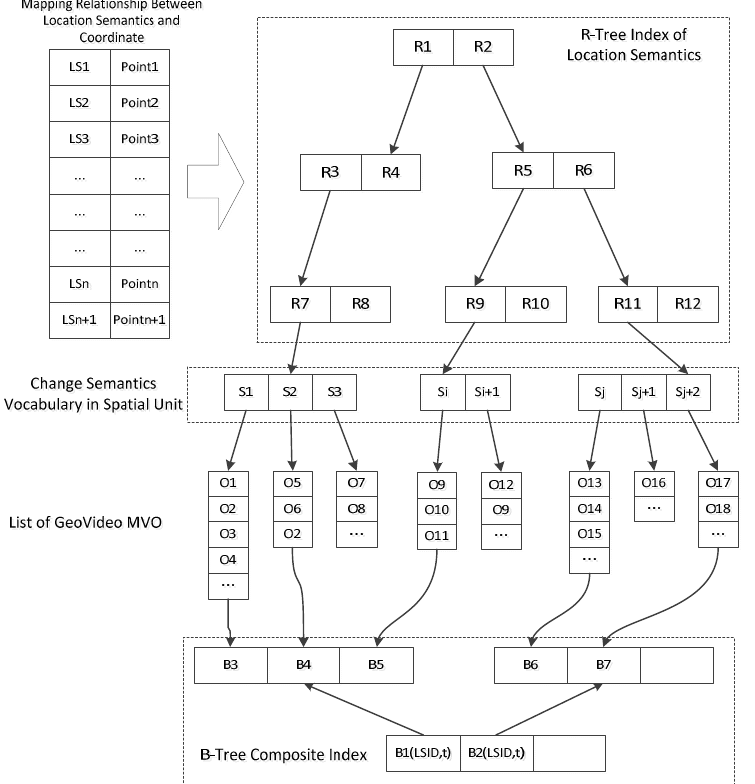
Figure 4. The spatiotemporal index concerned with change semantics.